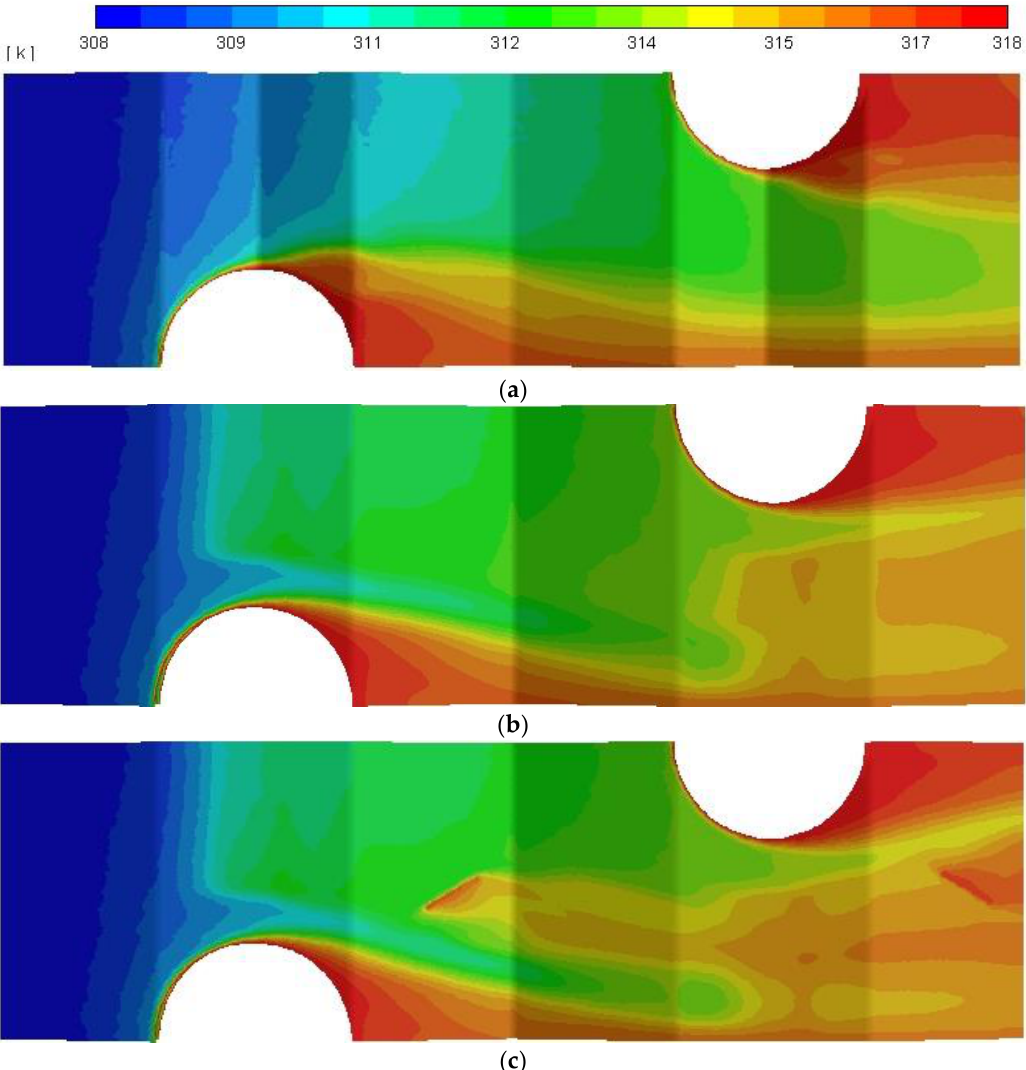
Figure 12. Air temperature contours in the middle of fin pitch ( u in = 2 m/s): ( a ) Reference wavy fins; ( b ) compound geometry without vortex generators; ( c ) compound geometry with vortex generators.